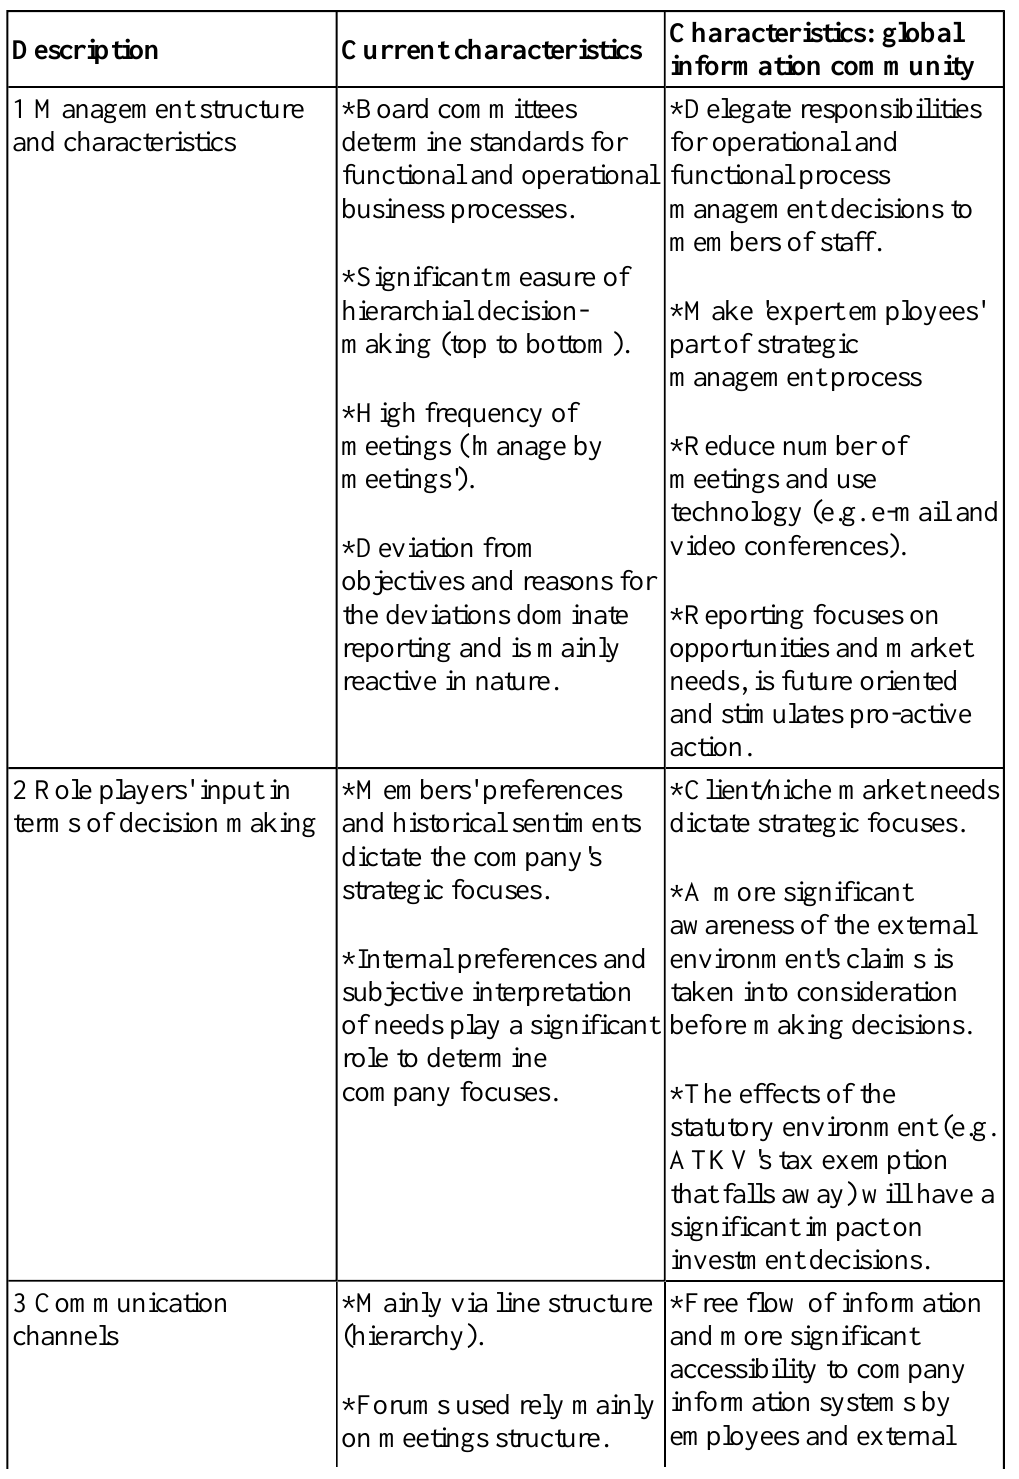
Table 3 Comparison between current and future ATKV management